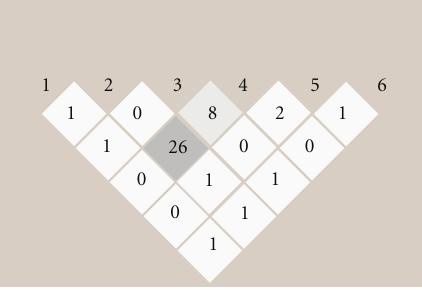
Figure 1: Values of r 2 (%) obtained from Haploview for pairs of the studied SNPs in the total sample of patients plus contact controls: rs4387996 downstream the BCHE gene (1); rs1126680 (2), rs1799807 (3), and rs1803274 (4) in the BCHE gene; rs4440084 (5) and rs2863381 (6) upstream the BCHE